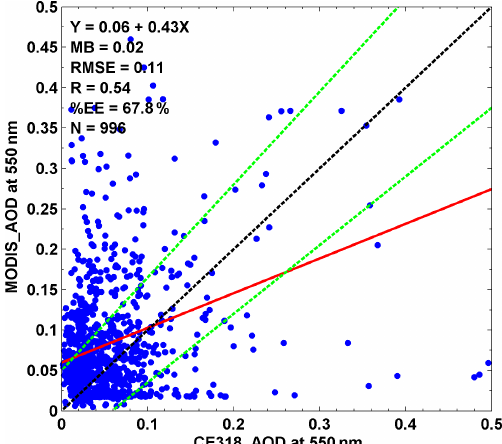
Figure 5. Comparisons of the 550nm AOD measured by the CE318 instrument (CE318_AOD) over Tibetan Plateau stations with the MODIS retrieval Deep Blue and Dark Target combined AOD of 10km spatial resolutions (MODIS_AOD). The statistical param- eters in this figure include the number of matchup data ( N ), the slope and intercept at the y axis of linear regression (read line), the mean bias (MB), the root-mean-squared error (RMSE), the correla- tion coefficient ( R ) and the percentage of data within the expected error 0 . 05 + 0 . 15 AOD (% EE) which is used as the MODIS AOD expected uncertainty over land (green